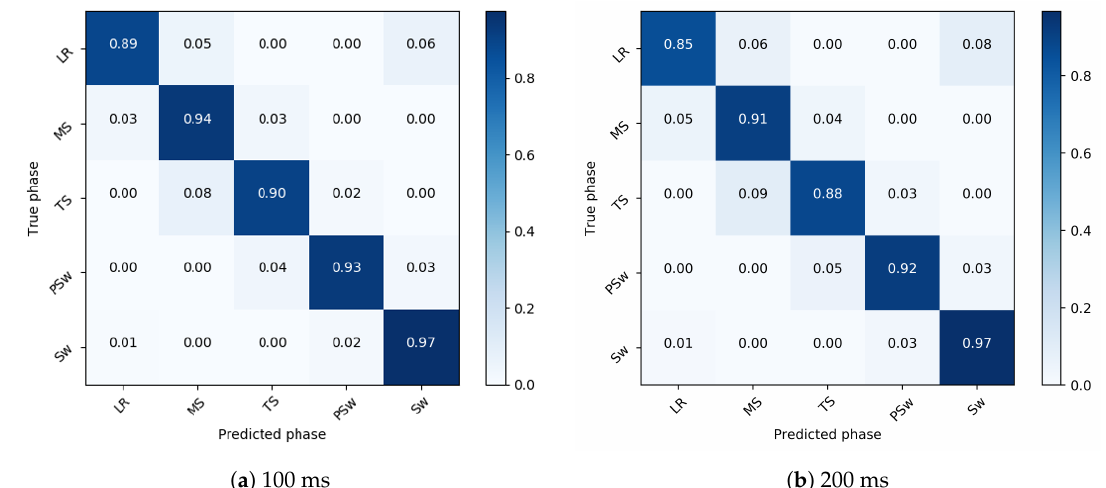
Figure 4. Confusion matrix showing the gait phase prediction accuracy of 100 ms ( a ) and 200 ms ( b ) ahead in the intra-subject implementation. The true gait phase is shown on the y -axis and the predicted phase is on the x -axis. A strong diagonal indicates very accurate prediction, and misclassifications are indicated off the diagonal.